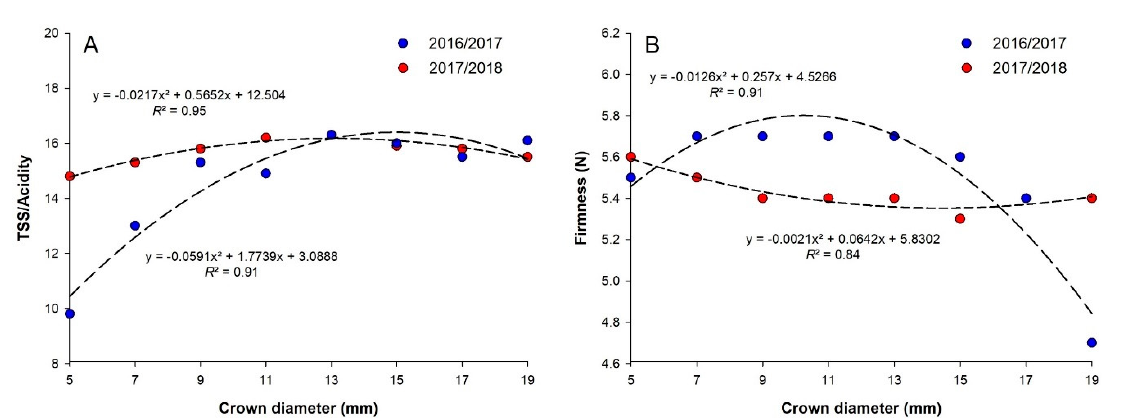
Figure 5. The response of the ratio between the content of soluble solids (TSS) by titratable acidity ( A ) and pulp firmness ( B ) of the fruits of strawberry plants cv. ‘Pircinque’, depending on different crown diameters of the plants (5, 7, 9, 11, 13, 15, 17, and 19 mm) during the 2016/2017 and 2017/2018 production